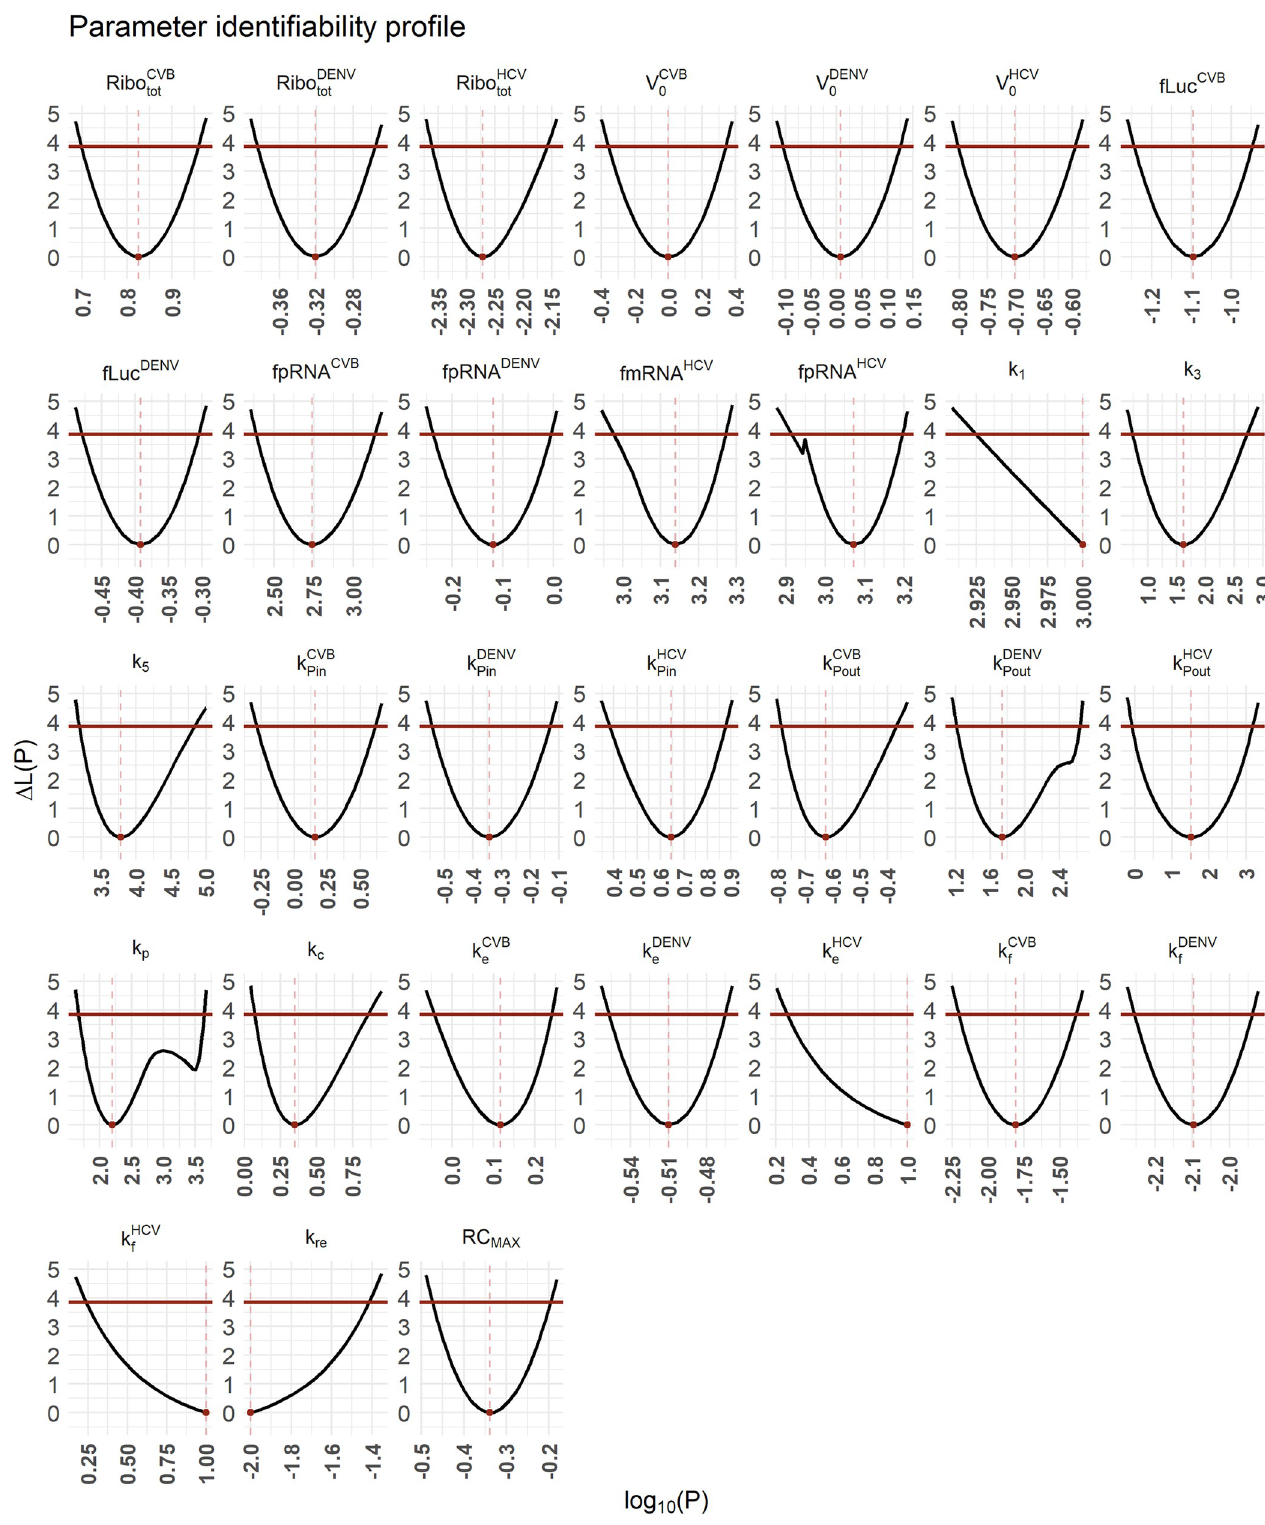
Fig 3. Uncertainty analysis of the best-fit model. For parameter values and 95% confidence intervals, see Table 2. The best fit is shown in Fig 2.